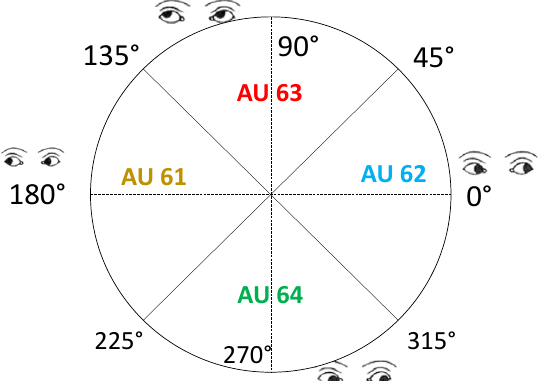
Figure 6. Quantization of the angle between the iris center and the eye center into eye movement action